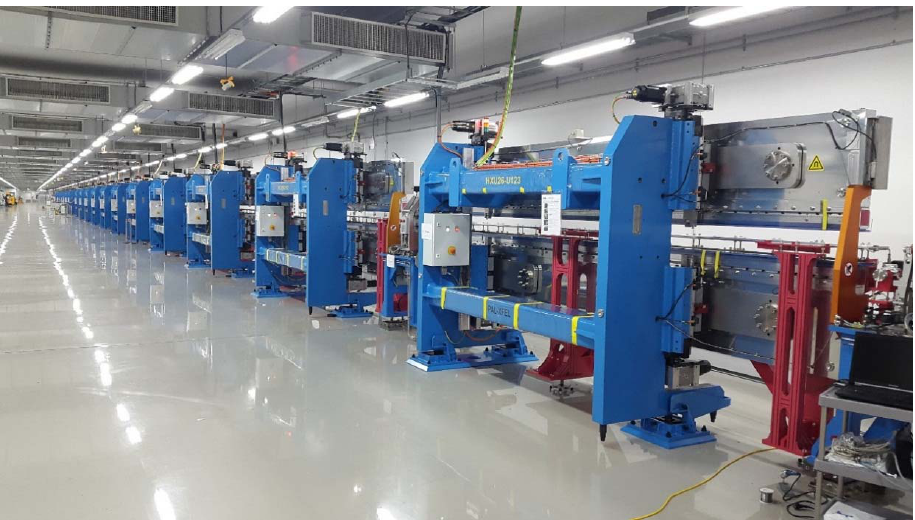
Figure 5. Hard X ‐ ray undulator tunnel of PAL ‐ XFEL.